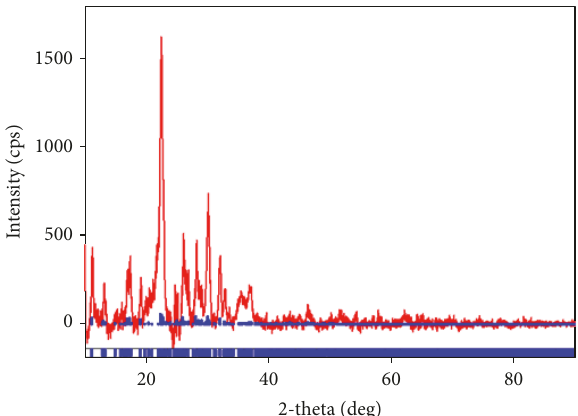
Figure 3: XRD analysis of the poly(AN-co-VP)/zeolite composite.